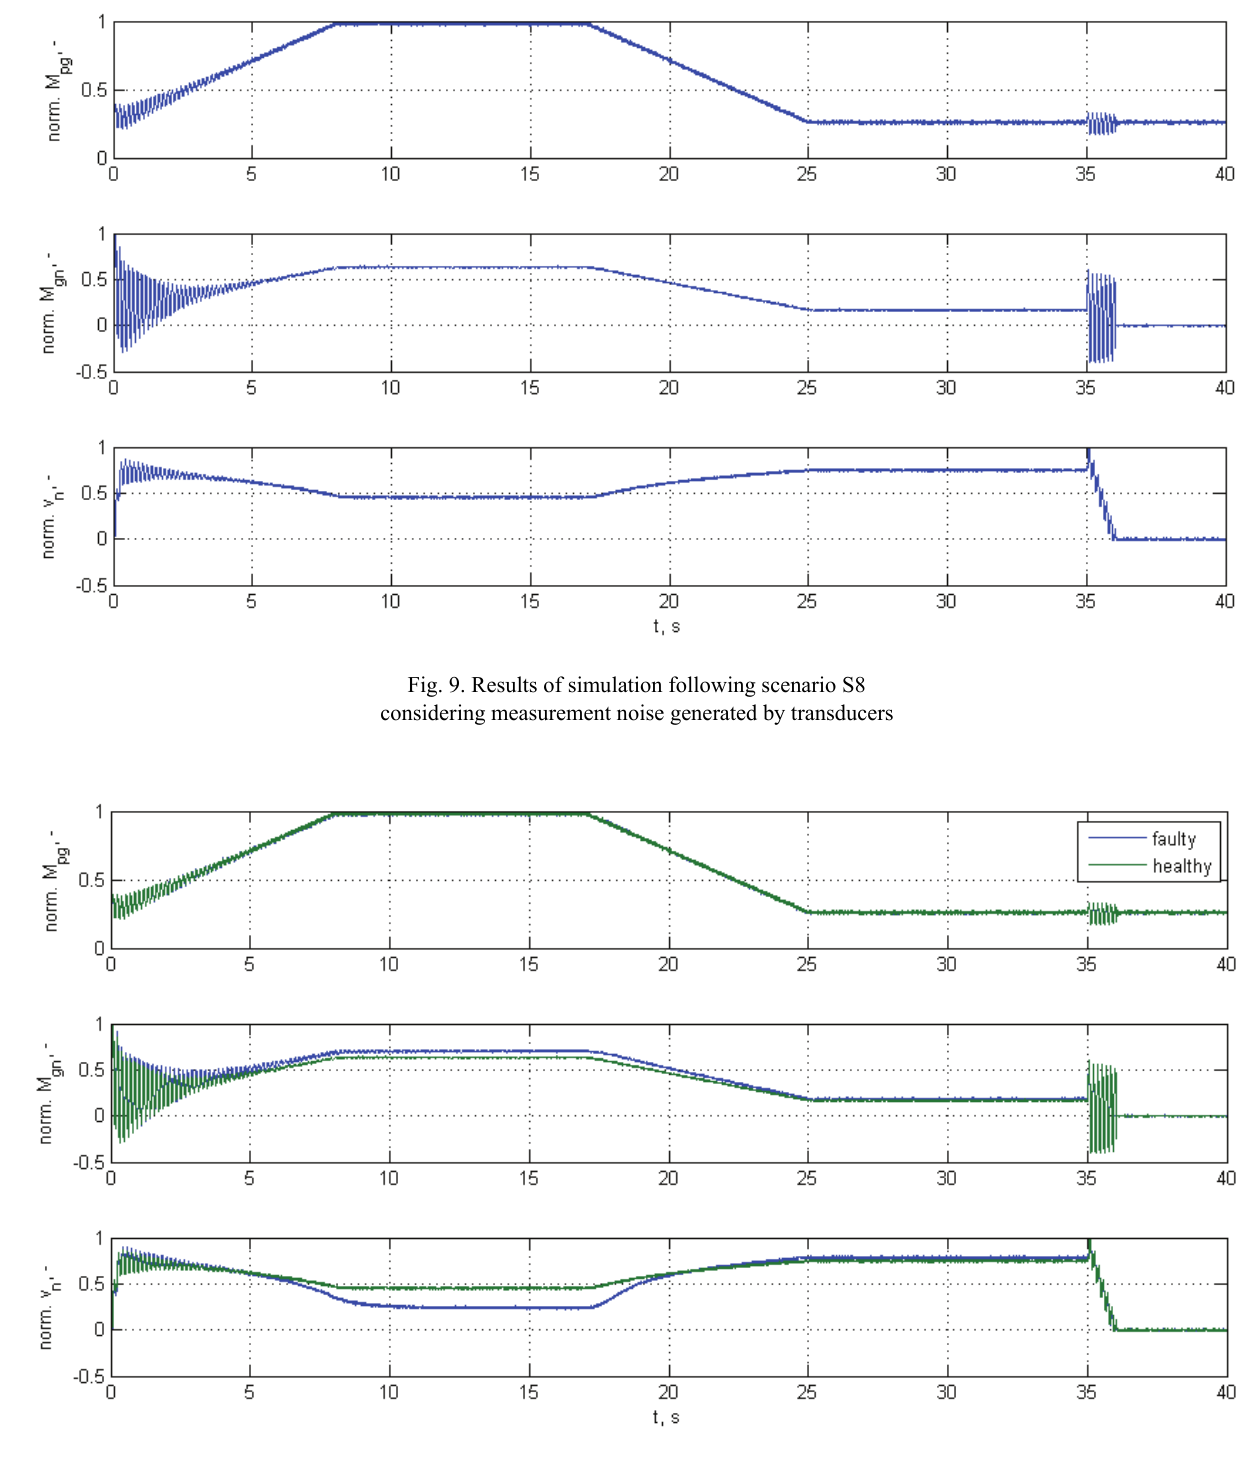
Fig. 10. Comparison of results of simulation following scenario S8 for healthy and faulty (U1)